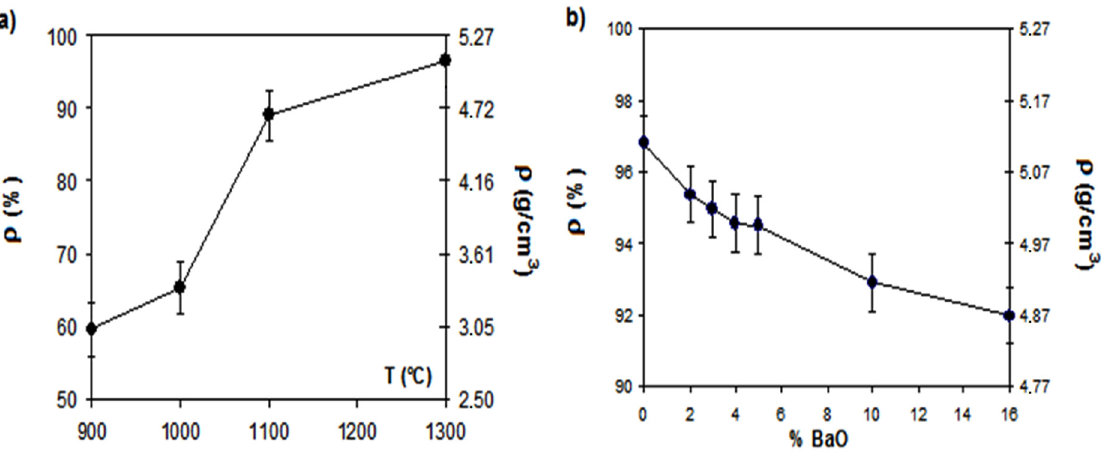
Figure 2. Geometrical density evolutions: ( a ) with temperature for 5% BA; ( b ) with barium oxide content for samples fired at 1300